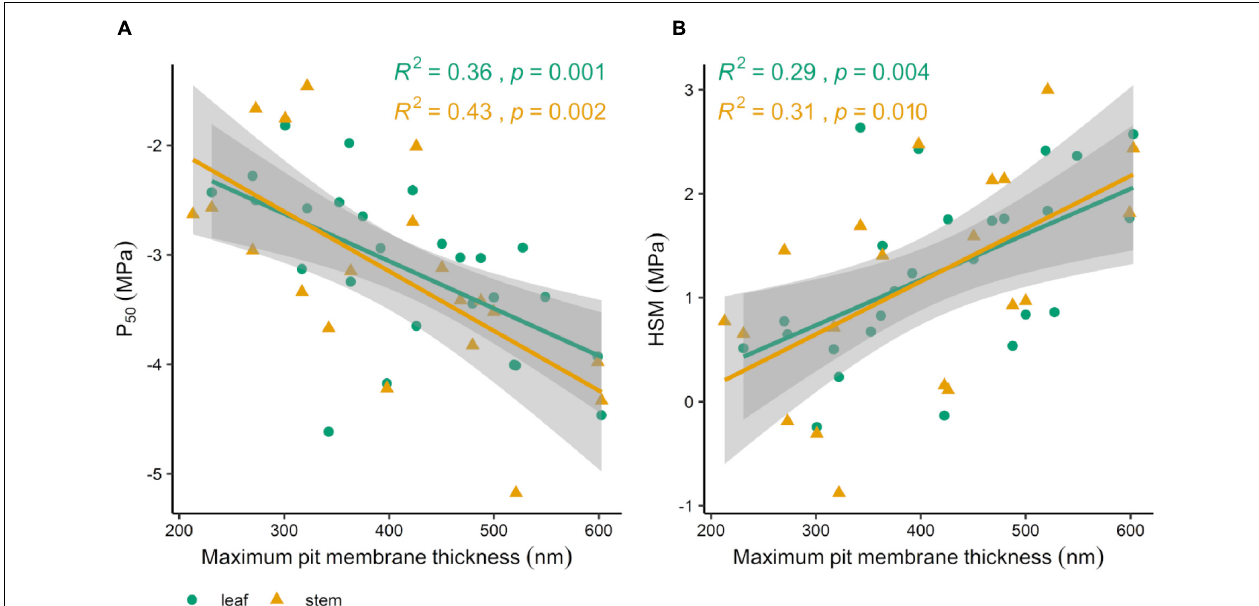
FIGURE 6 | Associations between maximum pit membrane thickness and P 50 (A) and hydraulic safety margins [HSM; (B) ]. Colors indicate whether P 50 and HSM were measured on leaves (green circles) or stems (orange triangles). Lines depict linear regressions and shaded areas represent 95% confidence